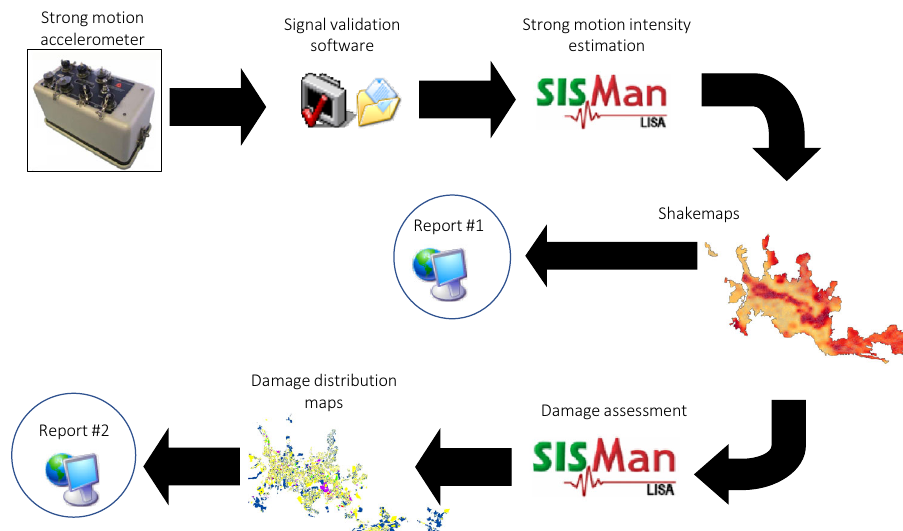
Fig. 5 General overview of the process followed to assess post-